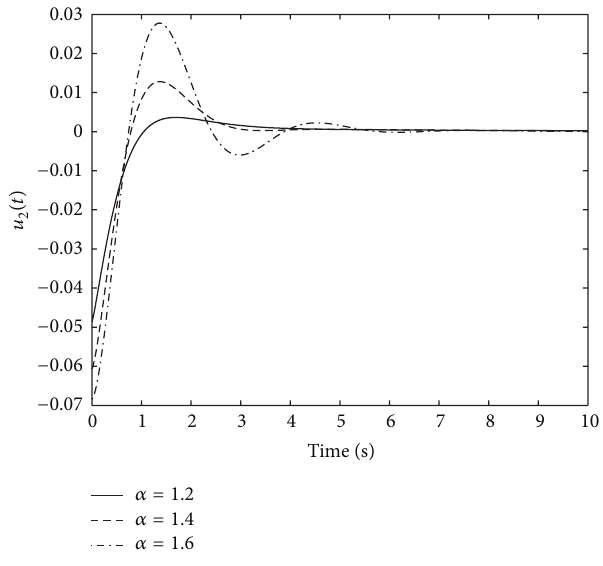
Figure 8: Control input 𝑢 2 (𝑡) (1 ≤ 𝛼 < 2)